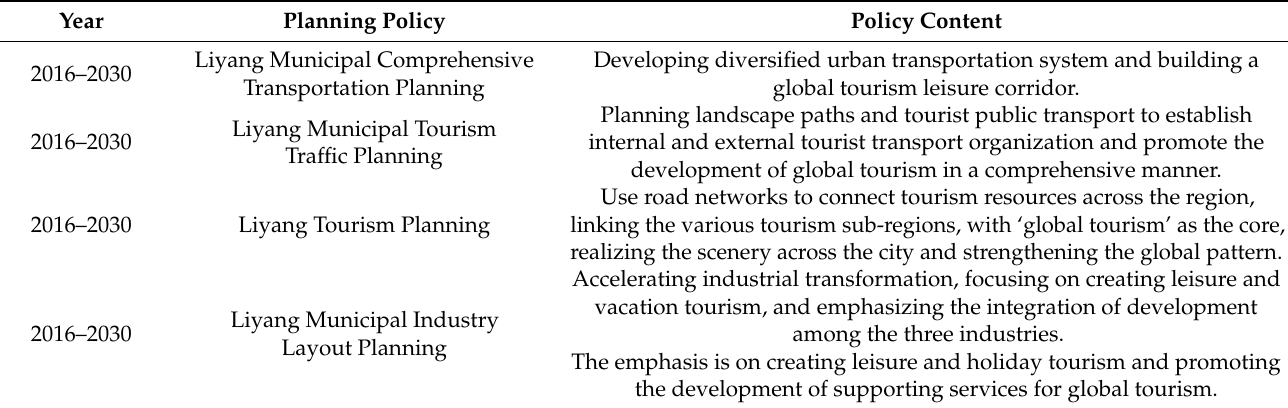
Table 4. List of the planning